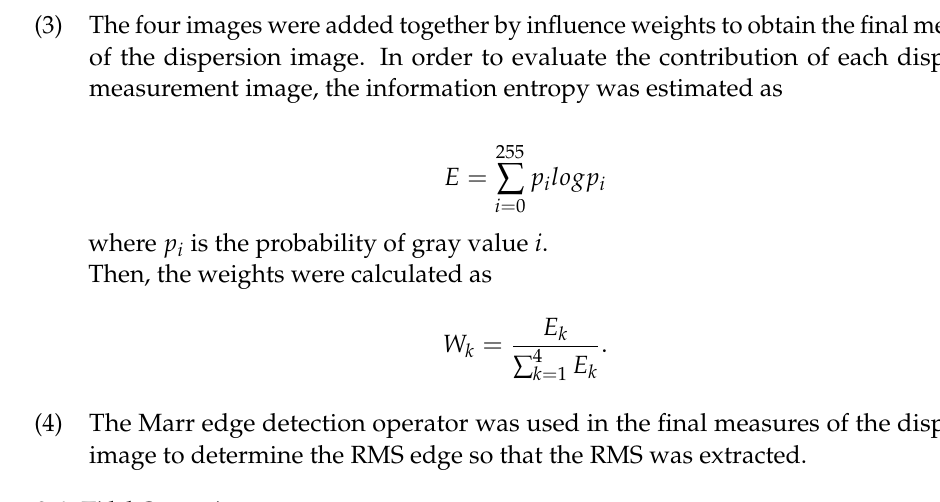
Figure 8. Extraction results of the RMS when using windows with different